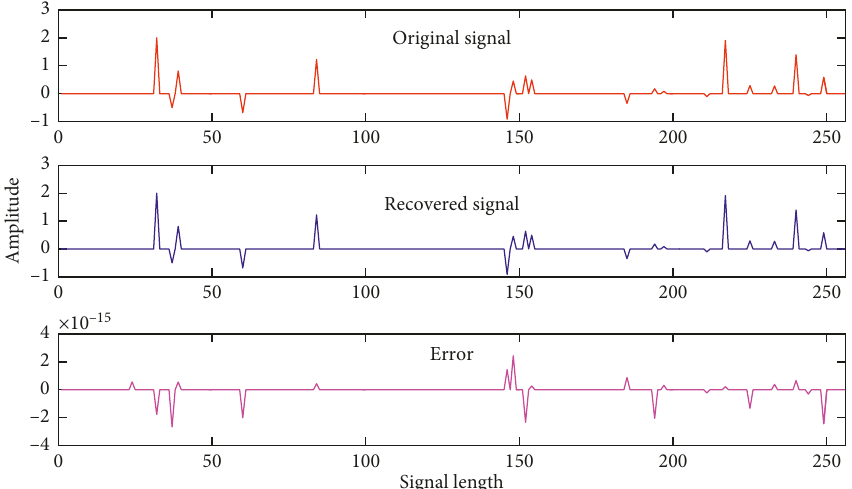
Figure 4: Comparison of original signal and recovery signal in the single reconstruction ( n